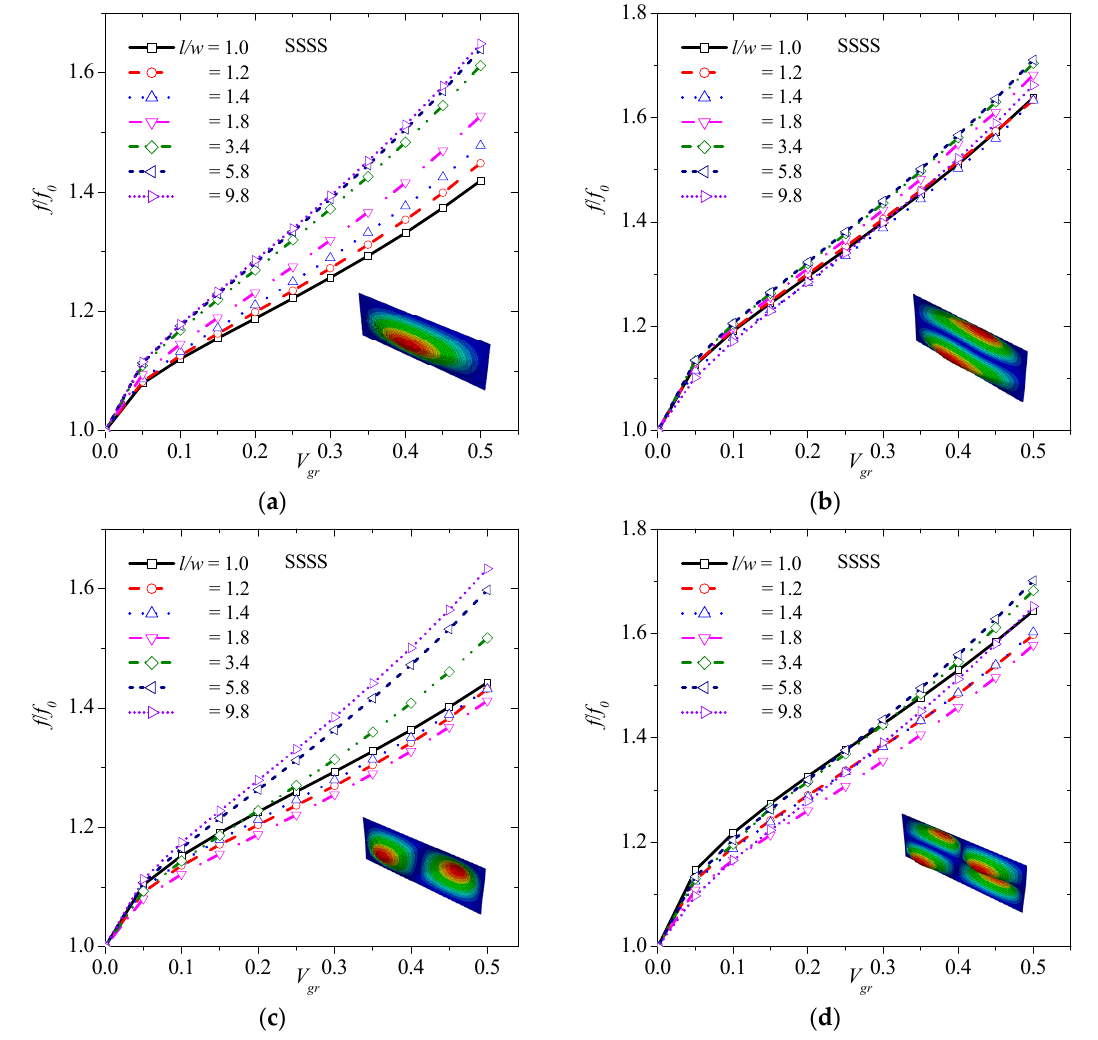
Figure 6. Normalized frequency versus volume fraction of graphene considering ( a ) (1,1), ( b ) (1,2), ( c ) (2,1), and ( d ) (2,2) vibration mode for SSSS boundary condition.